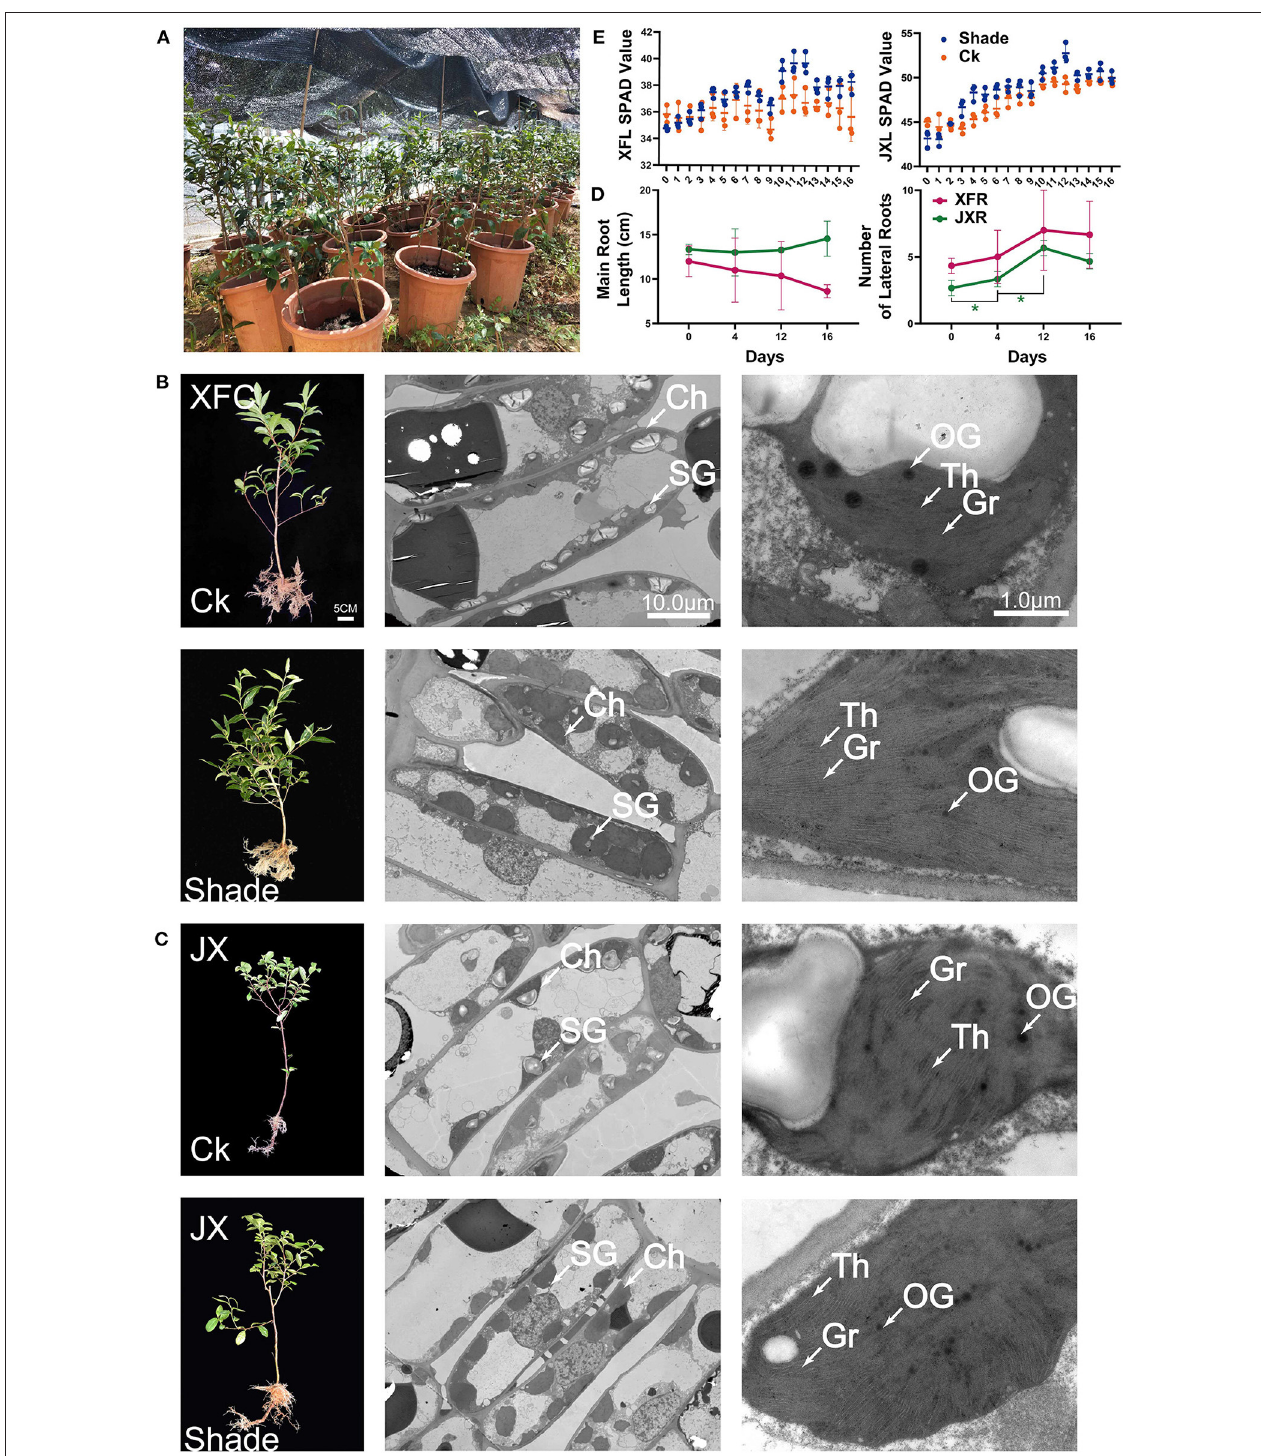
FIGURE 2 | Schematic of pot experiment (A) . Whole plant phenotype; effect of shading on the ultrastructure of cell organelles in leaves of two tea cultivars (B,C) . The values of main root length, lateral root number (D) , and SPAD (E) of two tea cultivars (means ± SD, three biological replicates per treatment group) under shaded and unshaded conditions. Data were assessed by one-way ANOVA followed by Duncan’s multiple range test. * p < 0.05. Ck, control check; Shade, shading treatment; XFC, “Xiangfeicui” cultivar; JX, “Jinxuan” cultivar; Ch, chloroplast; SG, starch granule; OG, osmiophilic granule; Gr, grana; Th, thylakoid; SPAD, soil and plant analyzer development, measuring relative chlorophyll content; XFL, leaf of “Xiangfeicui” cultivar; JXL, leaf of “Jinxuan” cultivar; XFR, root of “Xiangfeicui” cultivar; JXR, root of “Jinxuan” cultivar.